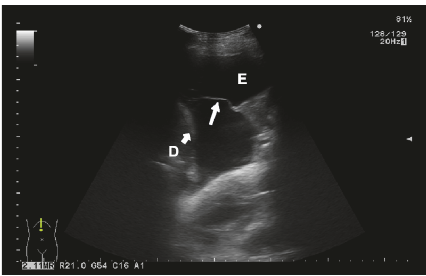
Figure 3: Floating visceral pleura due to atelectasis of the lung lobe (right white arrow). D = diaphragm (left bold white arrow); E = pleural effusion.